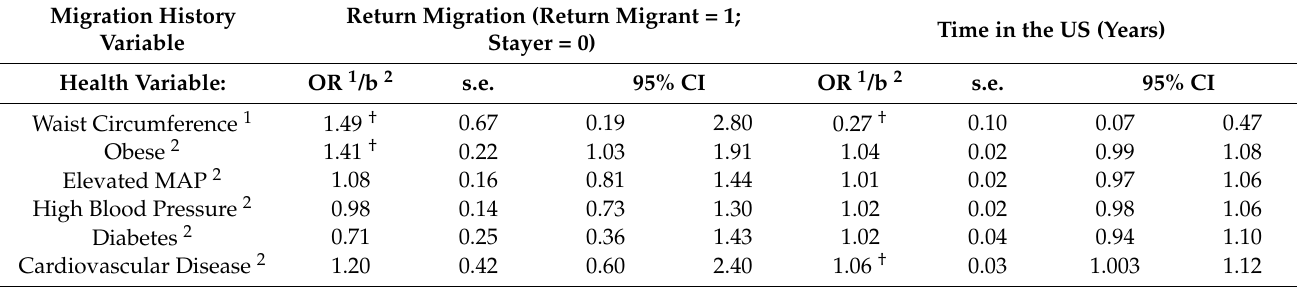
Mixed-effects regression models of the association between return migration and health and between time in the US and health; 1 beta coefficients are reported for dependent variables that were modeled using mixed-effects linear regression; 2 odds ratios are reported for dependent variables that were modeled using mixed-effects logistic regression. Controls include age, gender, marital status, education, employment status, insurance status, household assets, urbanicity, smoking status, and physical activity. † Indicates significance at p < 0.05 level. Models were adjusted for level 1 clustering at the family level and level 2 clustering at the locality